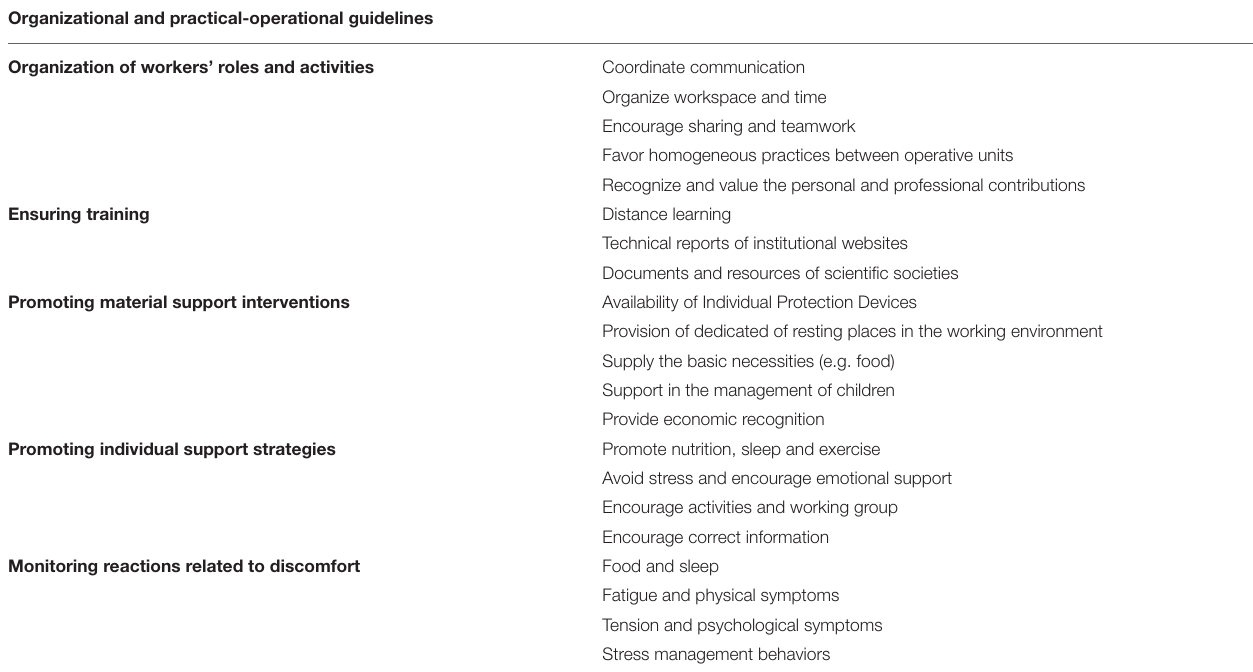
TABLE 2 | The management of physical and emotional challenging factors of health professional workers during the SARS-Cov-2 emergency scenario (ISS Working Group on Mental Health and Emergency COVID-19, 2020). Organizational and practical-operational